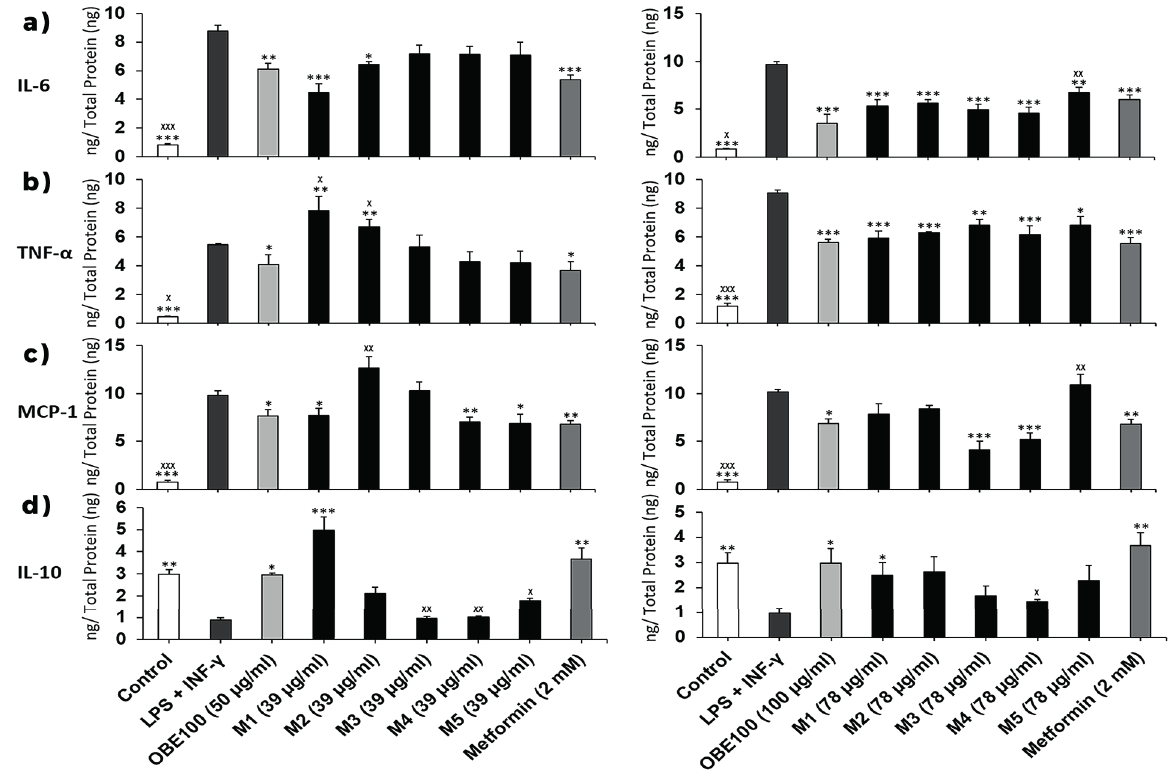
Figure 3. Effect of triterpenoid mixtures on activated J774A.1 macrophage protein expression . (a) IL-6, (b) TNF-α, (c) MCP-1 and (d) IL-10 concentration in culture supernatant is shown. Values are expressed as mean ± SEM of three independent experiments. Metformin was used as positive control. * < 0.05 vs LPS+INF-γ (activated cells), ** < 0.01 vs LPS+INF-γ (activated cells), *** < 0.001 vs LPS+INF-γ (activated cells), x < 0.05 vs OBE100, xx < 0.01 vs OBE100, xxx < 0.001 vs OBE100 (ANOVA with Dunnett´s post hoc